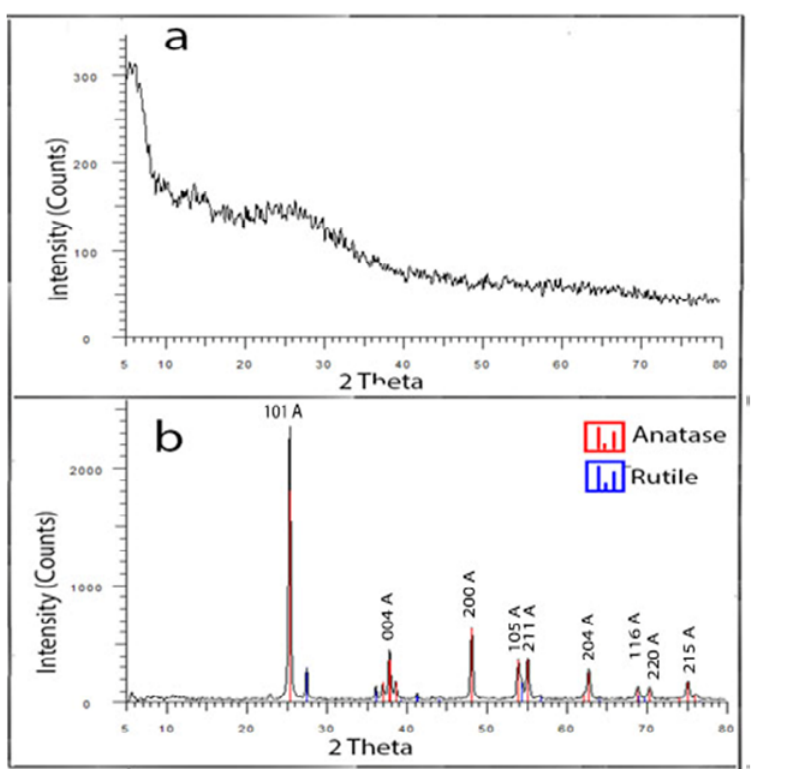
Figure 4. Thin film X-ray diffraction pattern a) Image of pure Silica Sulfuric Acid (SSA) phase structure; b) image of N,S-TiO